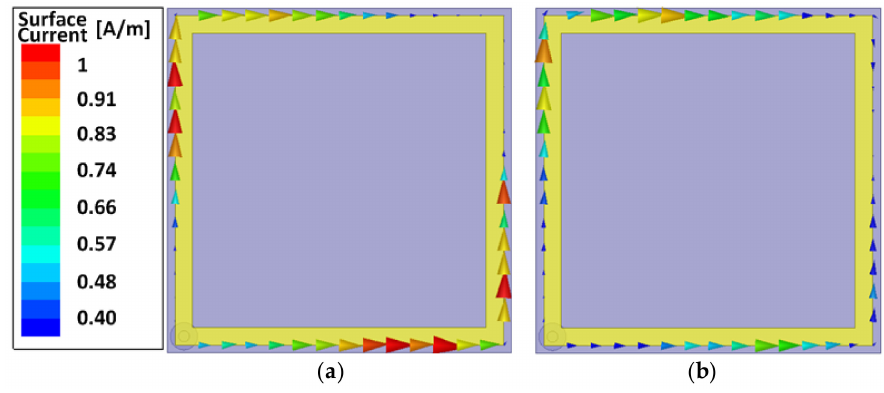
Figure 8. Simulated surface current distribution on the square-ring with different incidence angles ( a ) θ = 30 ◦ ; ( b ) θ = 60 ◦ .